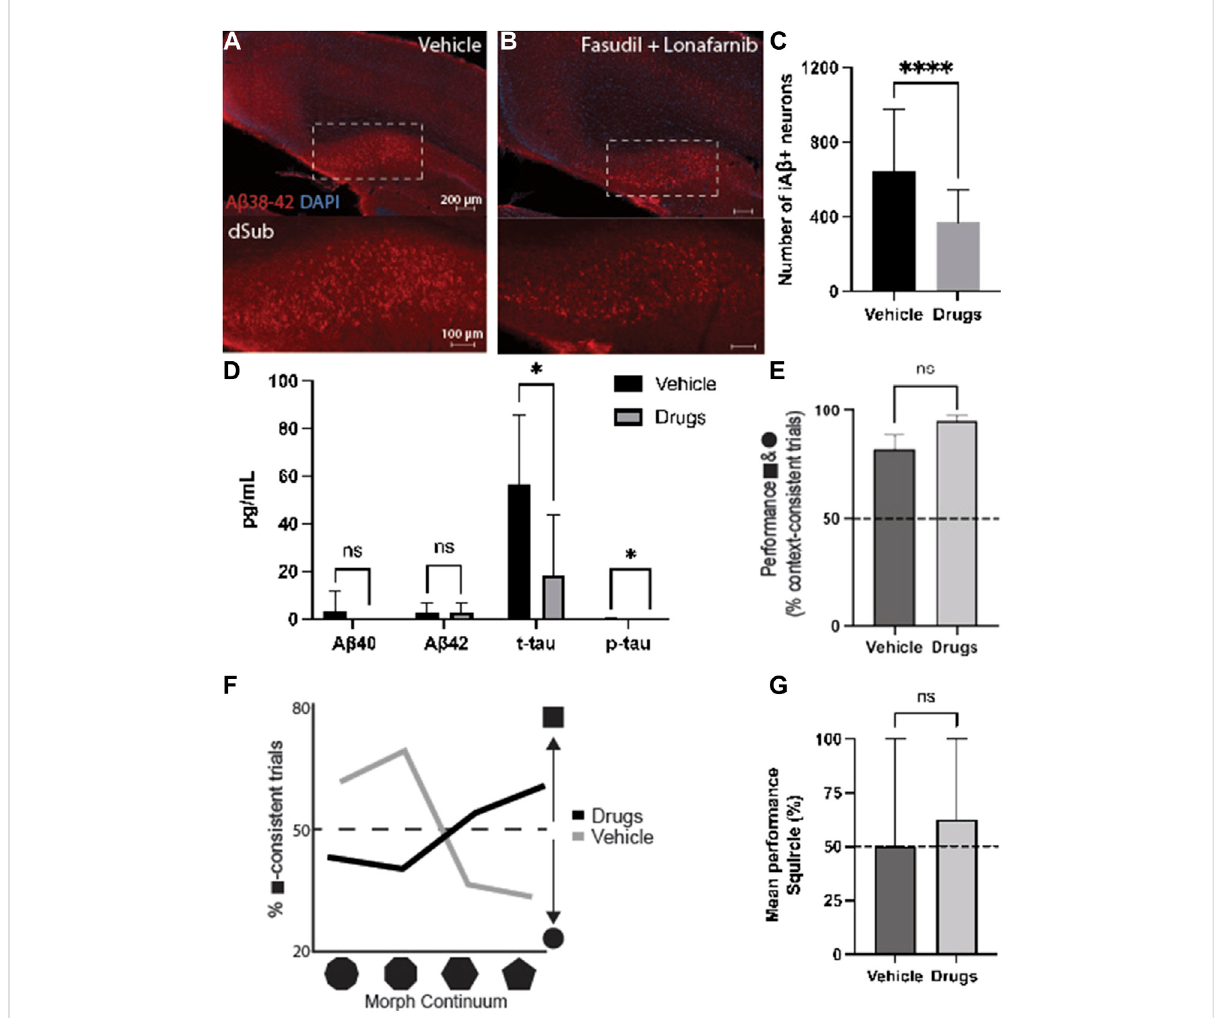
FIGURE 3 CombinatorialtargetingofWntandmTORpathwayseffectivelyattenuatesneuropathologyandcontext-dependentspatialmemoryde fi cits. (A) Intraneuronal A β 38-42 (McSA1; red) in dSub in 3xTg AD mice ( n = 4) receiving infusions of a vehicle (i.e., saline). DAPI counterstain (blue). (B) A β 38-42 (McSA1; red) immunoreactivity in dSub in 3xTg AD mice ( n = 4) receiving infusions of Fasudil and Lonafarnib. DAPI counterstain (blue). (C) Mean number of A β + neurons in dSub of 3xTg AD mice after infusions of a vehicle, or Fasudil and Lonafarnib. Intraneuronal A β in dSub was quanti fi ed from at least 7 brain sections for each animal using Ilastik. Error bars denote ±1 SD, unpaired two-tailed t -test, **** p < 0.0001. (D) Mean concentrations of duplicates of A β 40 , A β 42 , p-tau and t-tau CSF levels (pg/ml) as measured by multiplex ELISA on the last day of infusion (day 7) of a vehicle ( n = 6) or Fasudil and Lonafarnib ( n = 4) in young 3xTg AD mice. Error bars denote ±1 SD, unpaired two-tailed t -test, * p < 0.05. (E) Mean behavioral performance (% oftrials withcontext-appropriate choices)in3xTgAD mice infused with avehicle( n =3) or Fasudil and Lonafarnib ( n =4) in the square- and circle-chambers. Error bars denote ±1 SD, unpaired two-tailed t -test, n.s.: non-signi fi cant. (F) Percentage of trials with square context-consistent digs in 3xTg AD mice infused with a vehicle ( n = 3) or Fasudil and Lonafarnib ( n = 4) in each of the four morphed environments, ranging from most circle-like to most square-like in boundary geometry shape. (G) Mean behavioral performance (% of trials with context- appropriate choices) in 3xTg AD mice infused with a vehicle ( n = 3) or Fasudil and Lonafarnib ( n = 4) in the Squircle context. Error bars denote ±1 SD, unpaired two-tailed t-test, n.s.: non-signi fi cant. Abbreviations: A β , amyloid- β ; dSub, dorsal subiculum; iA β , intraneuronal A β ; t-tau, total tau; p-tau, phosphorylated